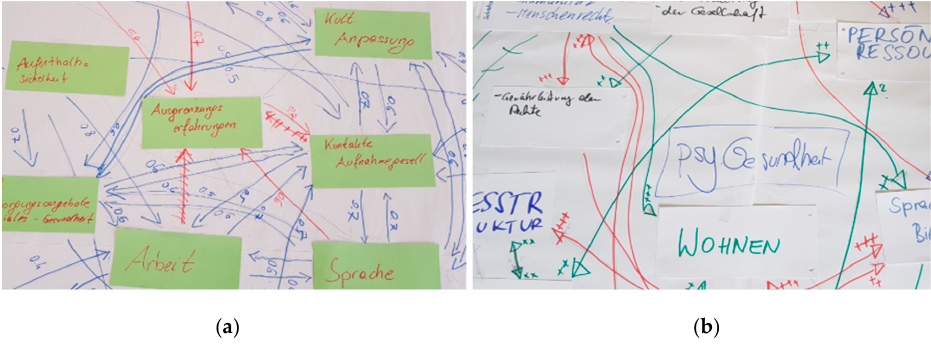
Figure 1. Part of the group system model of post ‐ migration risk factors in Austria co ‐ developed in workshop 1 with scientists ( a ) and workshop 2 with practitioners ( b